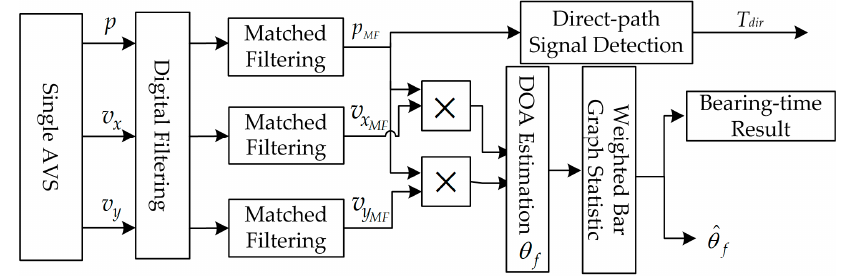
Figure 3. Principle chart of azimuth angle estimation based on matched filtering.